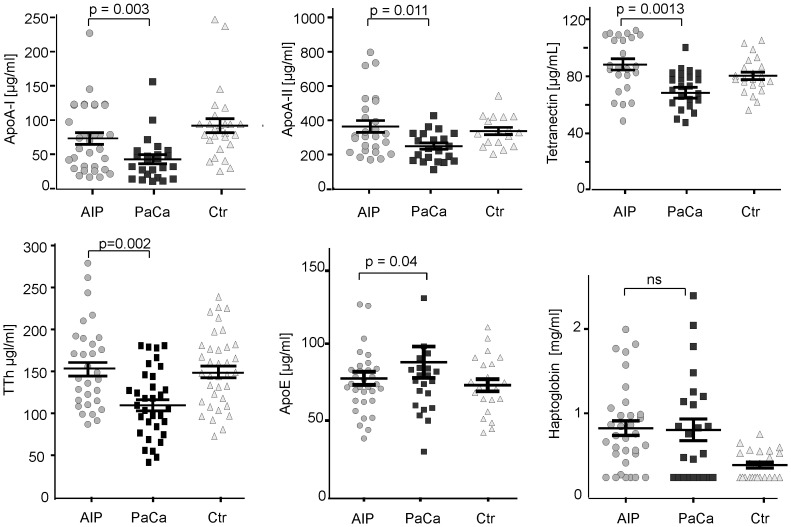
Serum levels and distribution of representative protein markers in sera from AIP-, PaCa-patients and controls assessed by ELISA.Dot plots of apolipoprotein A-I, apolipoprotein A-II, apolipoprotein E, transthyretin, tetranectin, and haptoglobin for each group. Statistical analysis was performed with GraphPad Prism5 applying Mann Whitney test (two tailed). Values are shown as a mean with SEM.